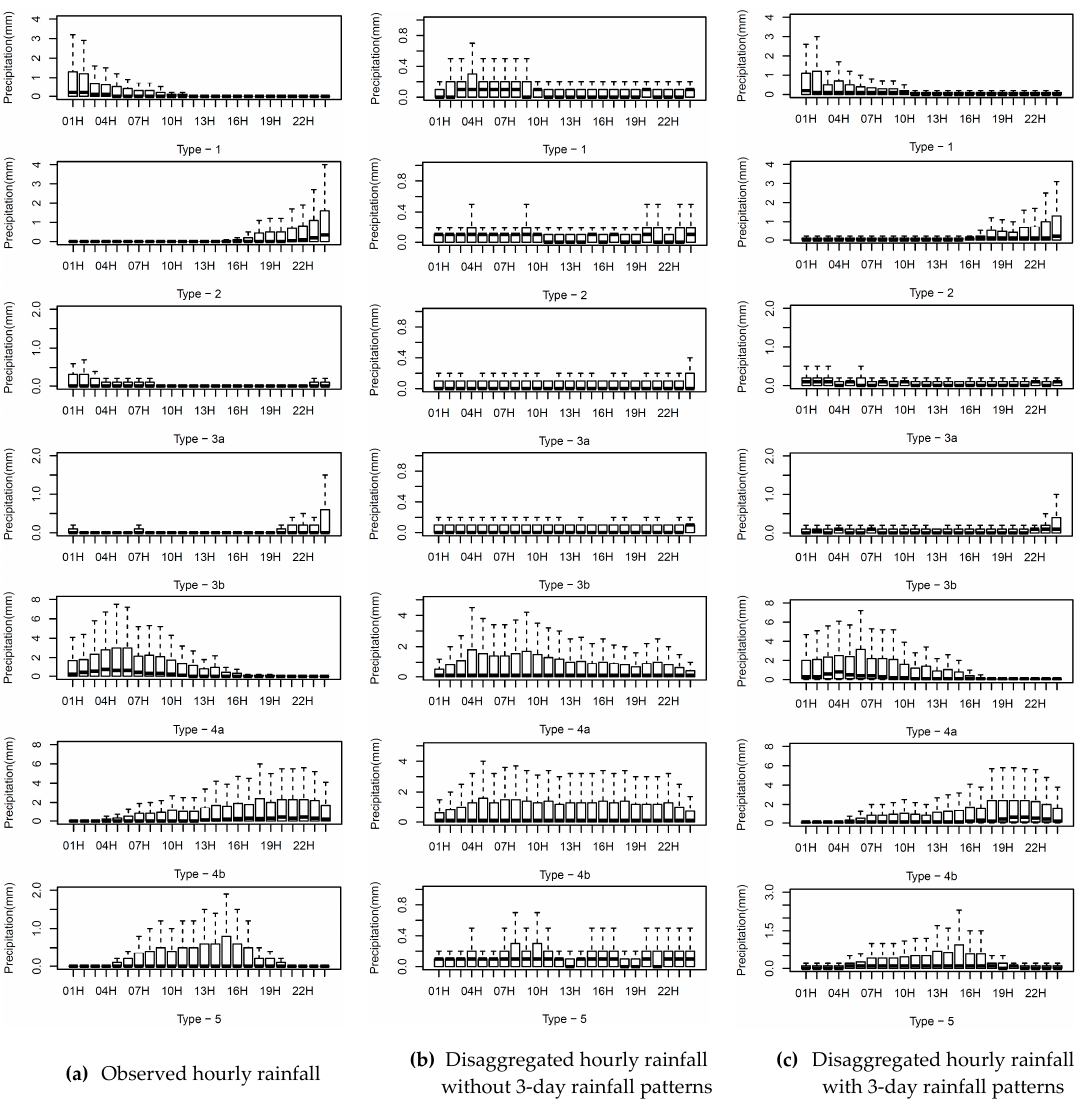
Figure 6. Hourly rainfall distribution in Busan station ( a ) observed (original) data, ( b ) KNNR method without 3-day rainfall patterns, and ( c ) the proposed KNNR method with 3-day rainfall patterns.